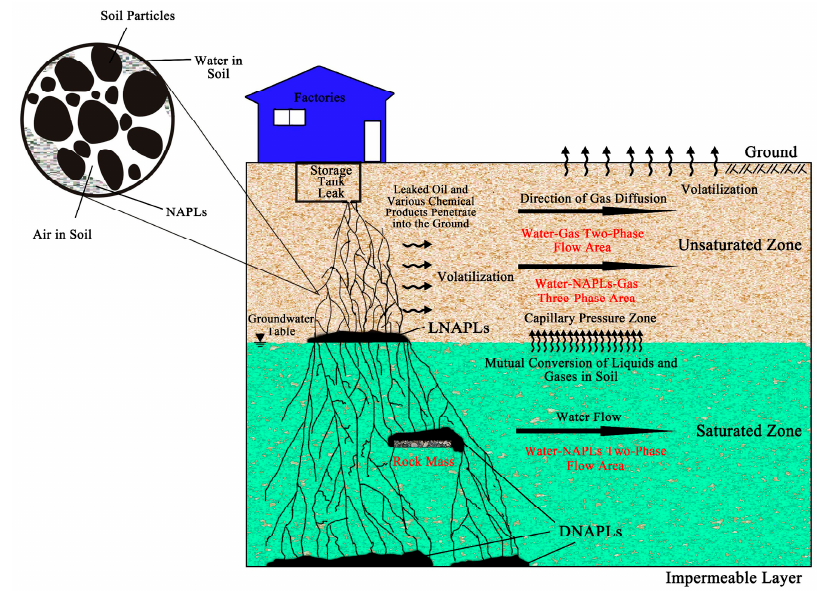
Figure 1. Schematic illustration of the subsurface transport mechanism of NAPL contaminants.